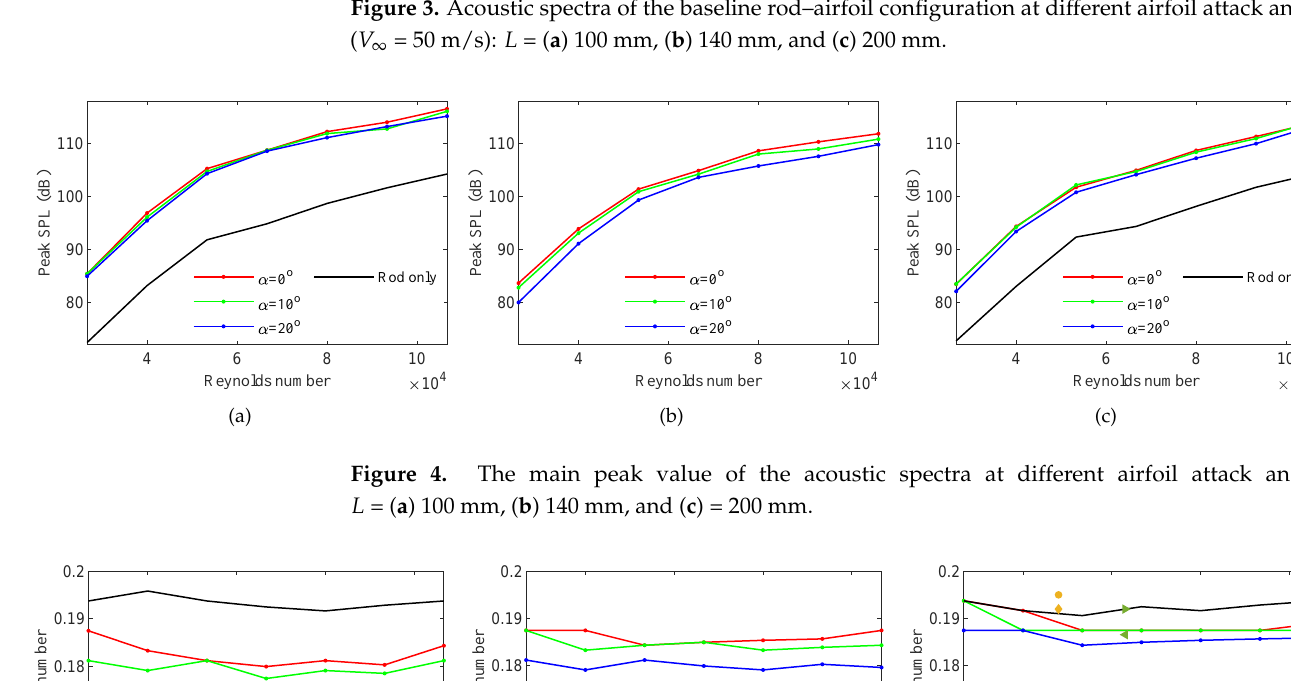
Figure 3. Acoustic spectra of the baseline rod–airfoil configuration at different airfoil attack angles